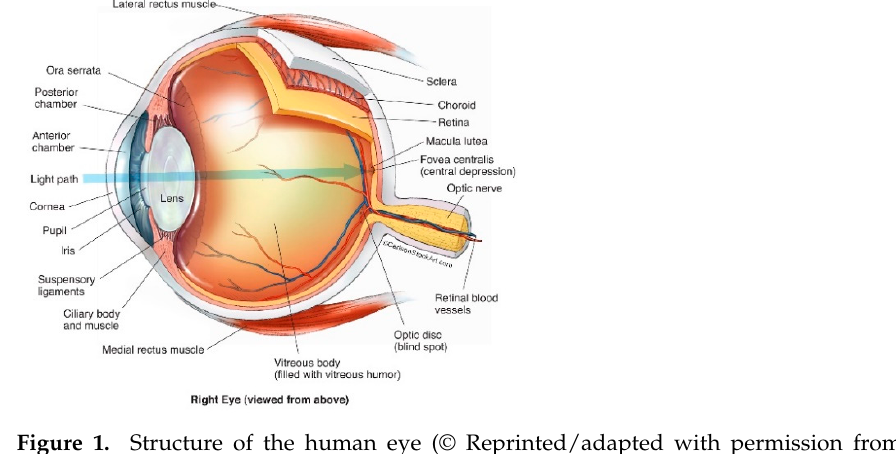
Figure 1. Structure of the human eye (© Reprinted/adapted with permission from Ref. [21] ( accessed on 25 May 2022)